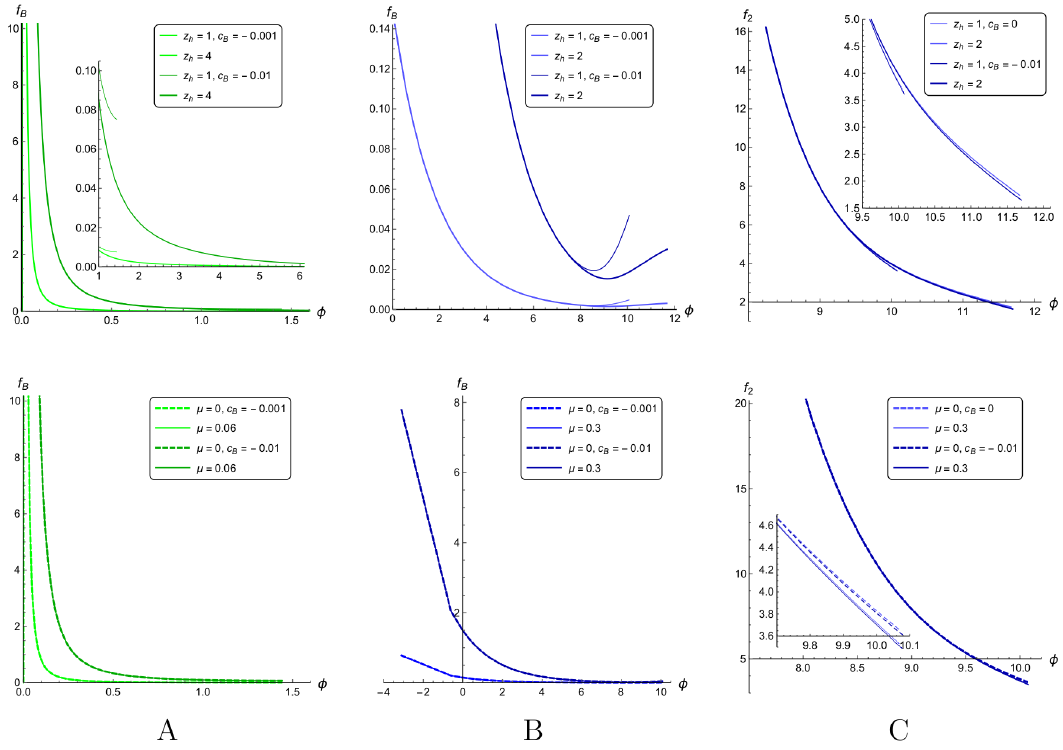
Figure 5 . Coupling function f B ( φ ) for c B = − 0 . 001 , − 0 . 01 , ν = 1 , (A), ν = 4 . 5 (B) and coupling function f 2 ( φ ) for c B = 0 , − 0 . 01 (C) for µ = 0 and different horizons (1-st line) z h = 1 , 4 (A) and z h = 1 , 2 (B,C) and for z h = 1 and different chemical potentials (2-nd line) µ = 0 , 0 . 06 (A) and µ = 0 , 0 . 3